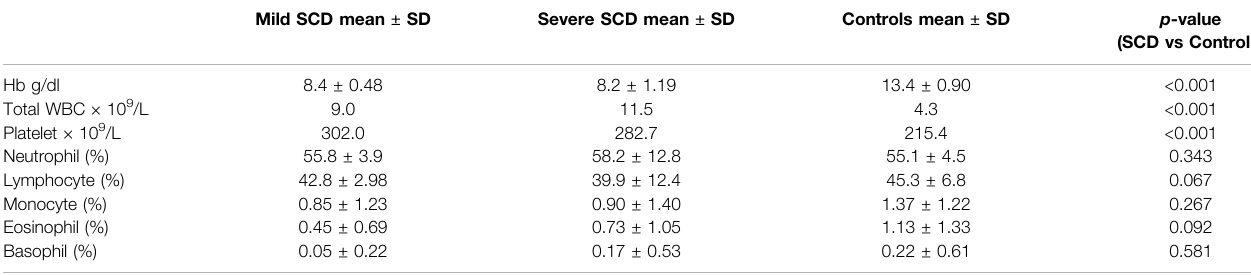
TABLE 1 | Full blood count in sickle cell disease patients and control individuals.